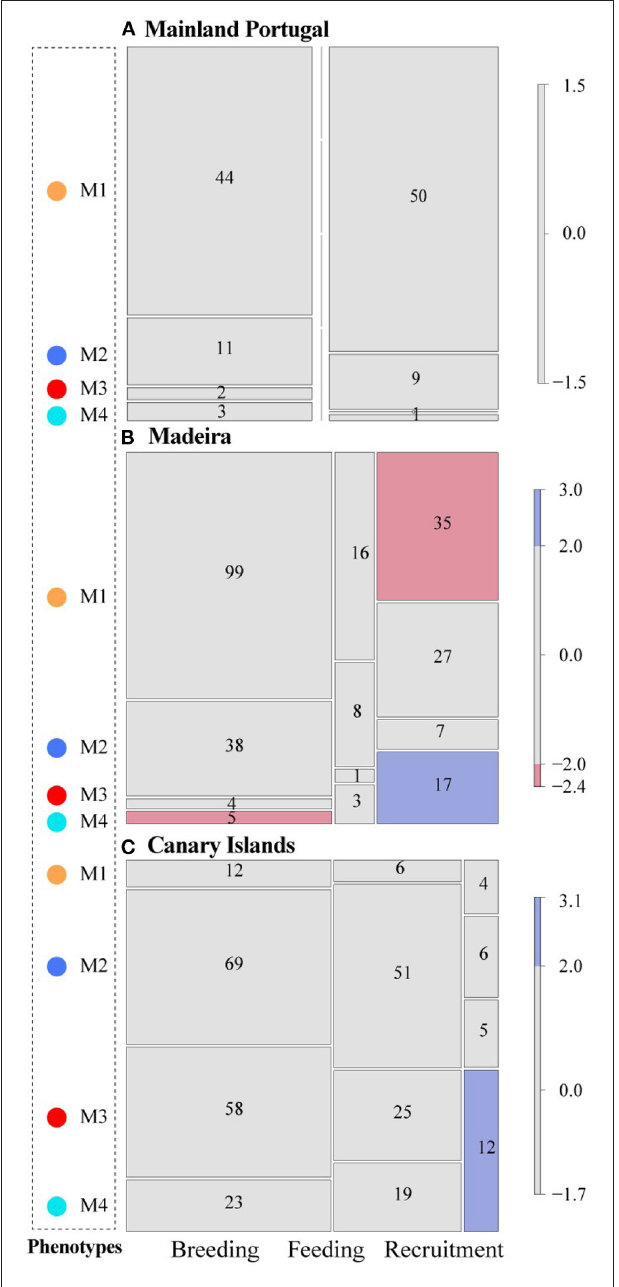
FIGURE 5 | Seasonal variation of the four otolith phenotypes found in Trachurus picturatus off the north and central eastern Atlantic Ocean. Breeding: January–April; Feeding: May–July; Recruitment: August–December (Jurado-Ruzafa and Santamaría, 2011, 2013). The number of specimens found by group is given. (A) Mainland Portugal, (B) Madeira, (C) Canary Islands. migratory behavior toward deeper waters only occurs in the recruitment period (warmest season), probably associated to the weak permanent upwelling (Gómez-Letona et al., 2017). In this context, the otolith shape of morphotypes (elliptic vs